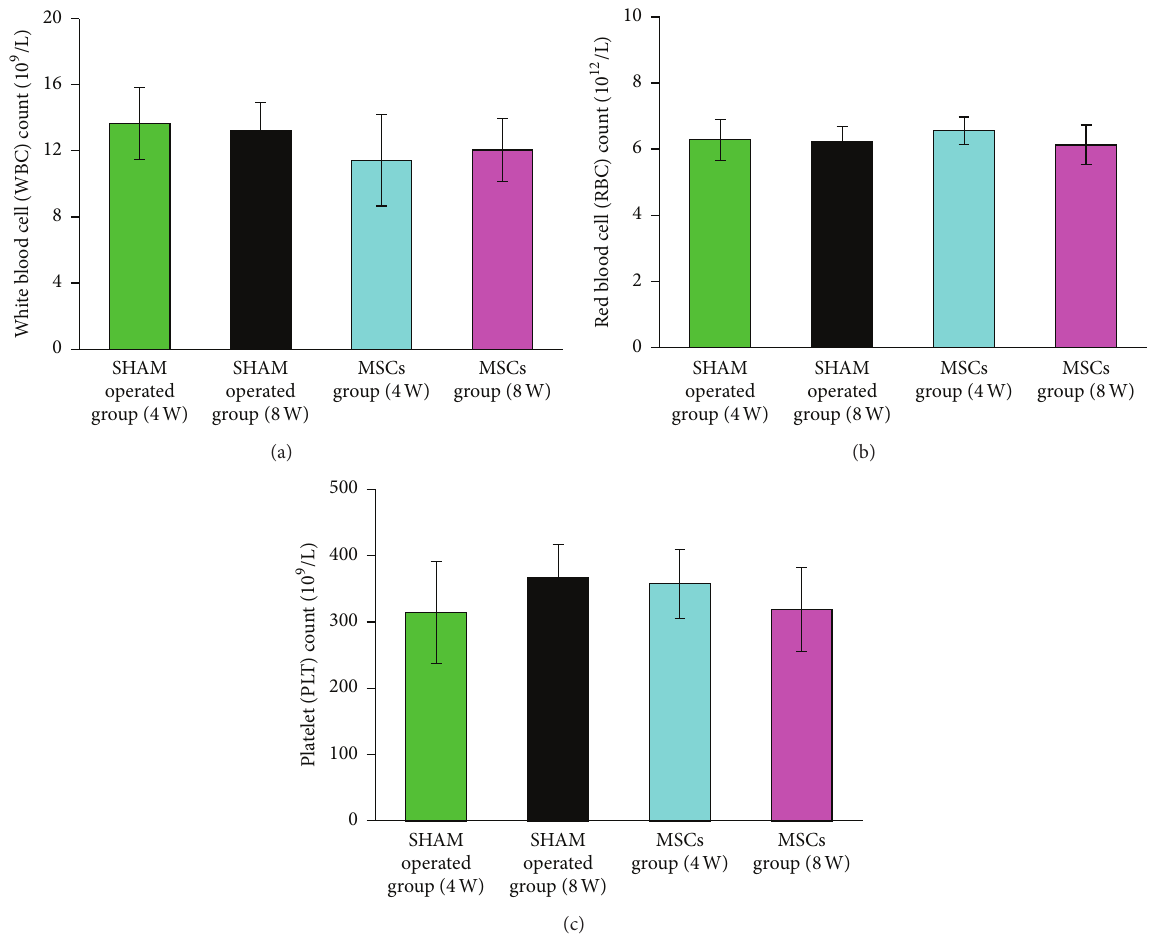
Figure 5: The difference of white blood cell (WBC) counts, red blood cell (RBC) counts, and platelet (PLT) counts between the two groups at 4th and 8th week after treatment. At 4th and 8th week after treatment, the white blood cell (WBC) counts, red blood cell (RBC) counts, and platelet (PLT) counts between MSCs group and SHAM operated group showed no significant difference ( 𝑝 > 0.05 ) (a, b,